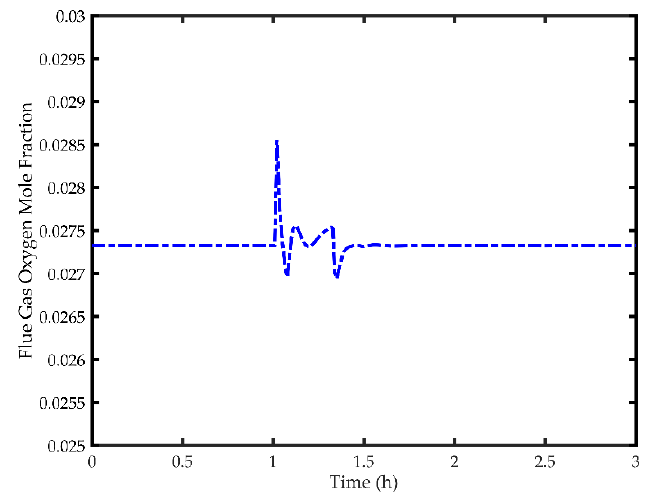
Figure 15. Response of the Boiler Outlet Oxygen Mole Fraction to a 60% Reduction in Load. Table 3. Comparison of Coal Compositions for Disturbance Rejection